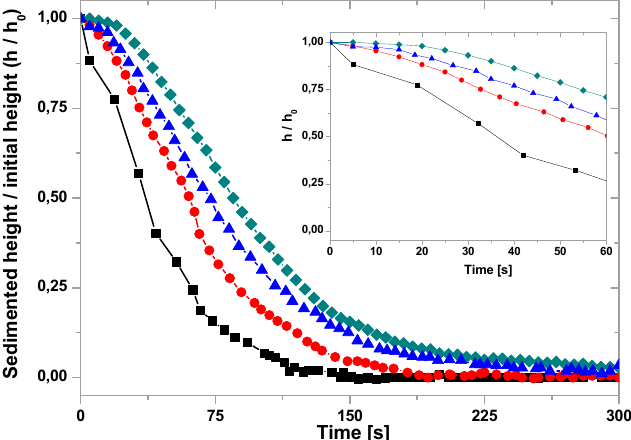
Figure 6. Height of the sedimented volume relative to its initial value as a function of time for MNPs ( ■ ), BMNPs ( ● ), 60 B + 40 M ( ▲ ), and 25 B + 75 M ( ♦ ). Inset: Short-time detail.